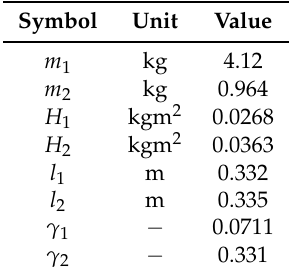
Table 1. Design parameters of a robotic leg.